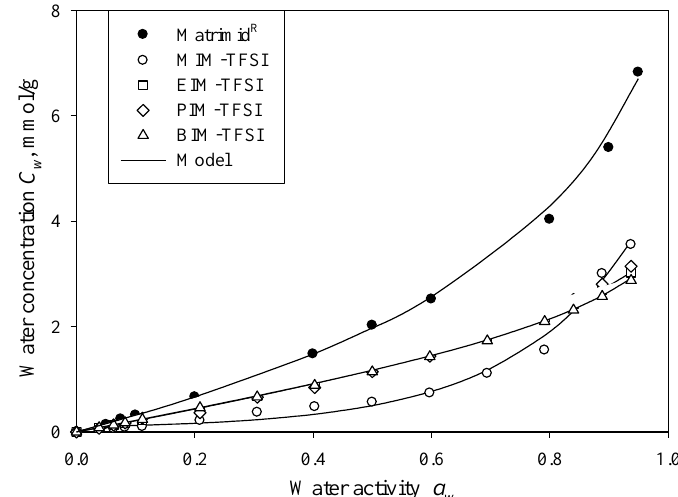
Figure 9. Water vapour sorption isotherms of the elaborated Matrimid ® /PIL composite membranes at 25 ± 1 °C. Solid lines are the best fit of the D’Arcy and Watt model (Equation (9)). Table 5. The D’Arcy and Watt model parameters (Equation (9)), the mean relative deviation modulus E (Equation (8)) and the Young’s modulus values for the Matrimid ® /PIL composite membranes. Model’s Parameters Membrane